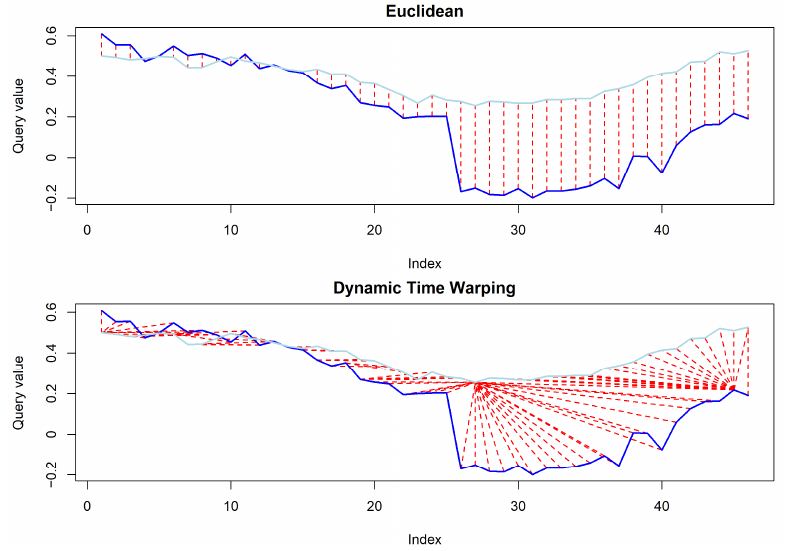
Figure 5. The phenology of the areas before and after the fire can be compared to each other by applying the dynamic time warping (DTW) method. All computations were performed in R [61] using the “dtw” package [62]. Dark-blue lines correspond to the reflectance of a burned area, while light-blue lines correspond to the reflectance of a vegetated area. Both lines were extracted from the 8-days composites within a year (46 observations in total) and are presented here as an example. Red lines are the one-to-one match for the Euclidean matching and the one-to-many match for the dynamic time warping matching.